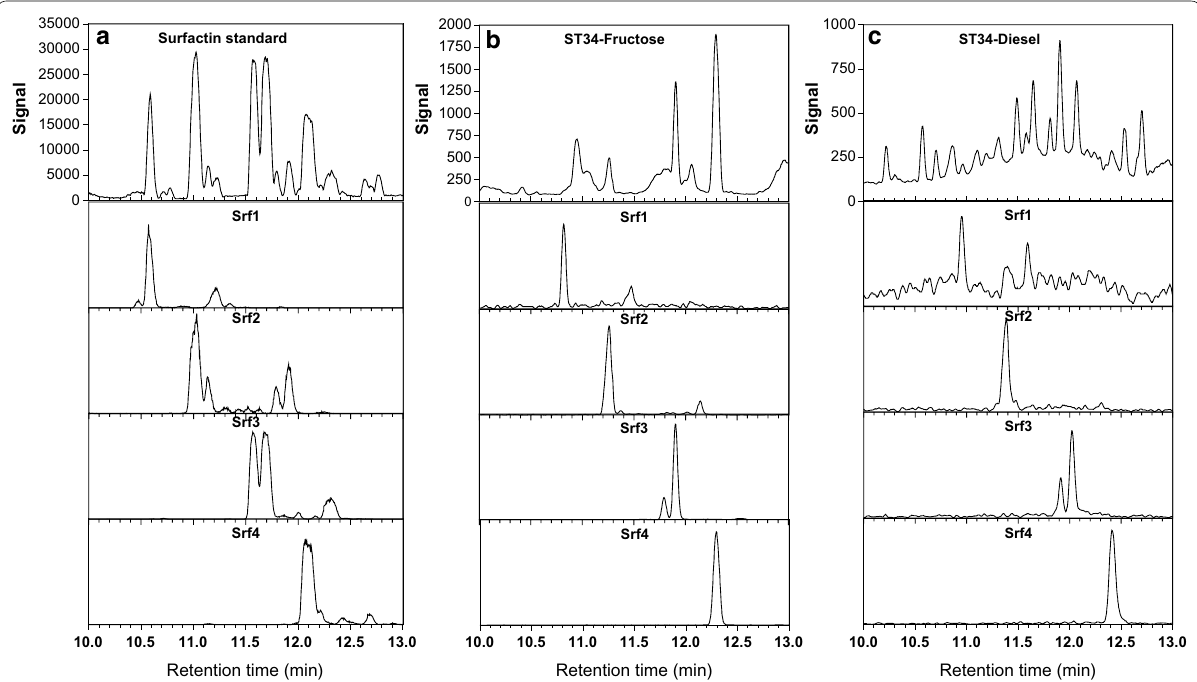
Fig. 1 UPLC–MS profiles of the surfactin standard ( a ); ST34 Fructose-MSM extract ( b ); ST34 Diesel-MSM extract ( c ). The top row profiles depict the signal of positive molecular ions detected between 10 and 13 min. Note the difference in Y axis which are a direct indication of amounts. The pro- files below each top row spectrum show the extracted spectra of the four surfactin groups with Srf1 1022.68 and Srf4 m/z 1036 =